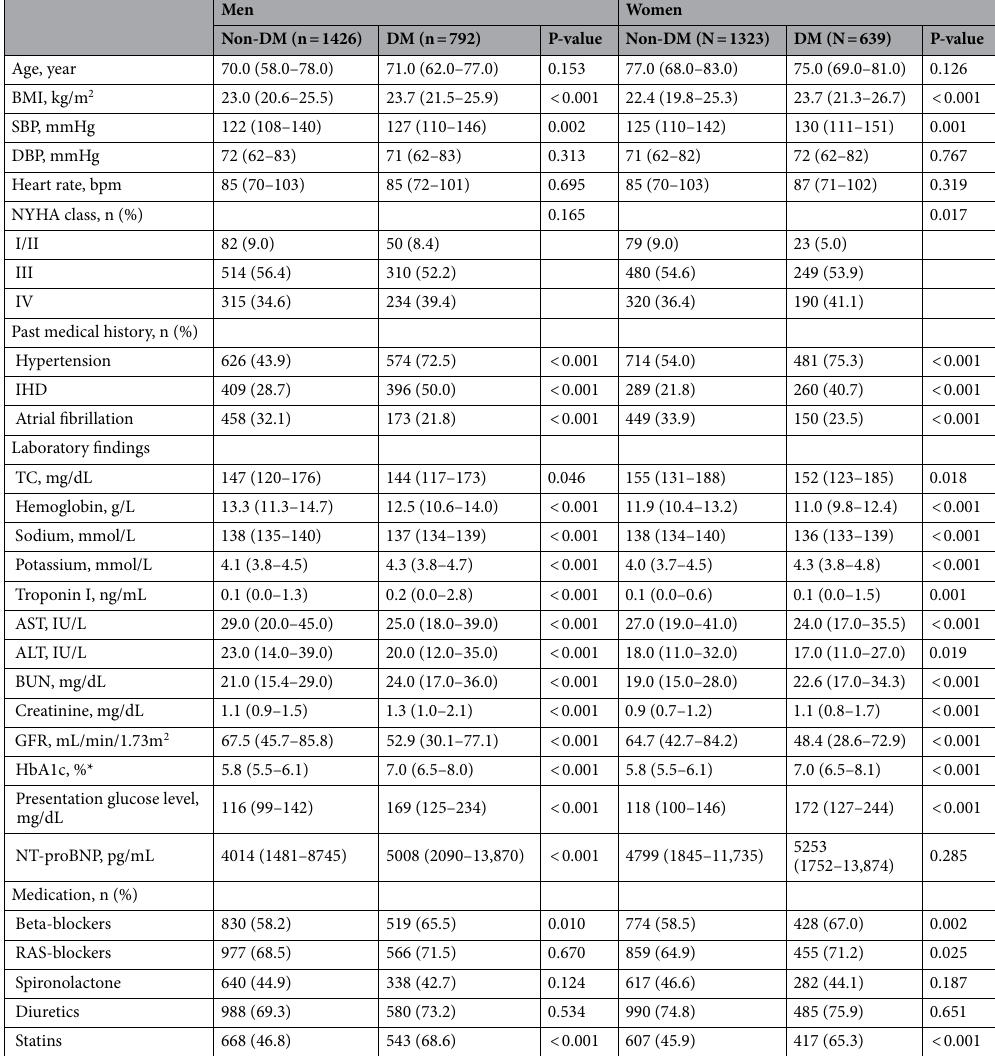
Table 1. Baseline characteristics of the study participants according to sex and DM status. Values given as number (percentage), or median (interquartile range) unless otherwise indicated. *HbA1c data was available in 42.3% patients. ALT = alanine aminotransferase; AST = aspartate aminotransferase; BMI = body mass index; BUN = blood urea nitrogen; DBP = diastolic blood pressure; DM = diabetes mellitus; GFR = glomerular filtration rate; HbA1c = glycated hemoglobin; IHD = ischemic heart disease; NT-proBNP = N-terminal pro- brain natriuretic peptide; NYHA = New York Heart Association; RAS = renin-angiotensin system; SBP = systolic blood pressure; TC = total